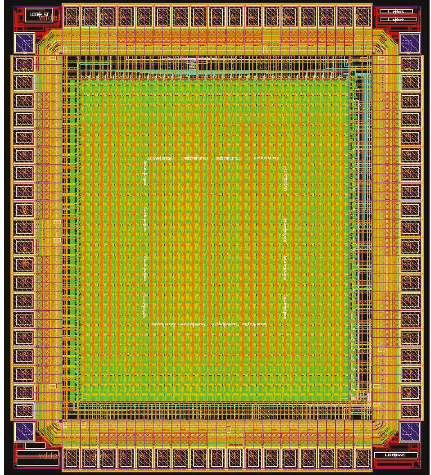
Figure 10: Layout of the 32 × 32 AME processor array. The active processing area of 16 × 16 cells is highlighted in the middle or the array.